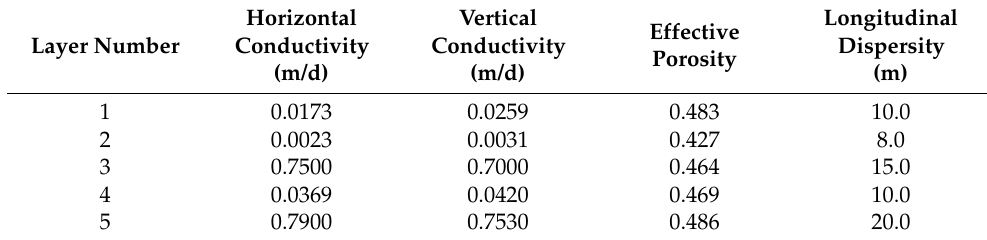
Table 3. Hydrogeological parameters in the